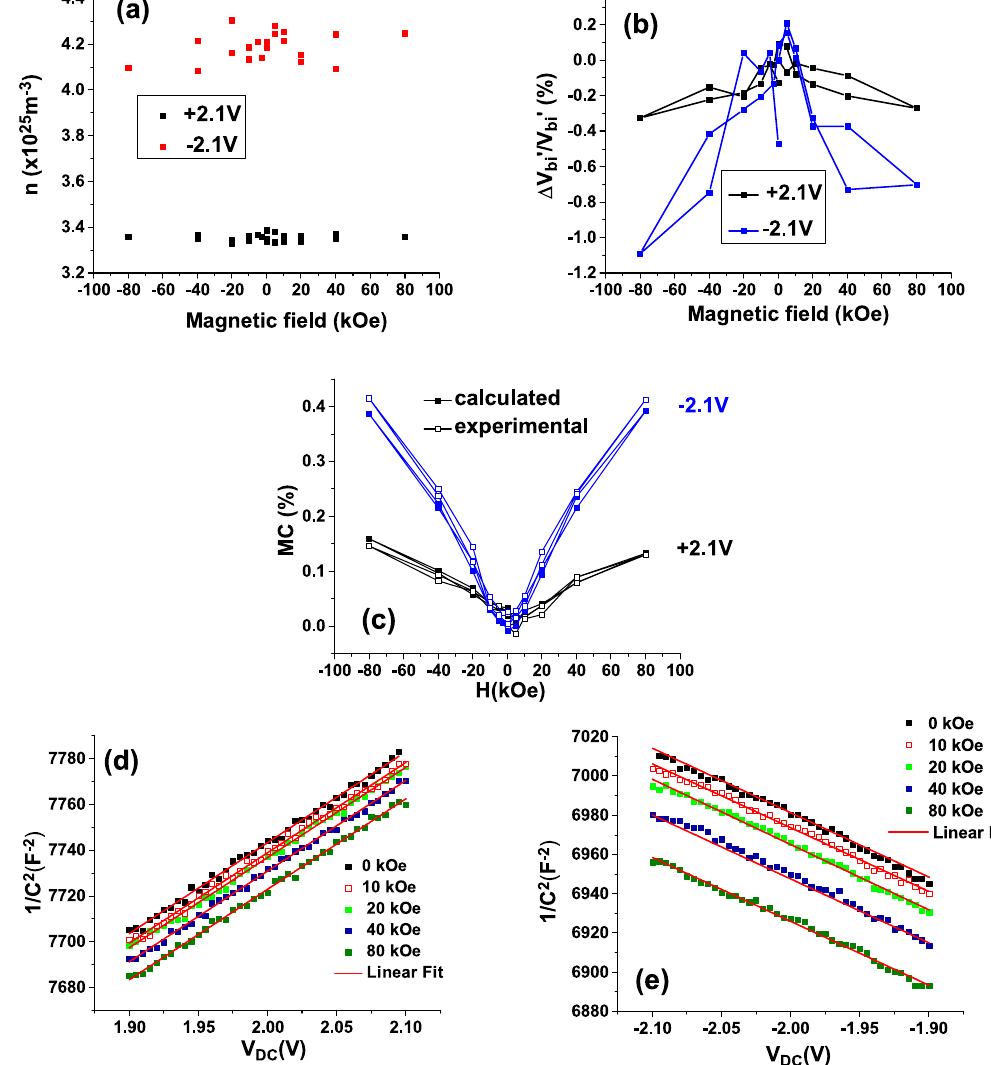
Figure 7. ( a ) Magnetic field dependence of the free carrier concentration and ( b ) of the apparent built-in potential V bi ′ ; ( c ) comparison between the experimental (open symbols) and calculated (full symbols) MC values. The lines shown on ( b ) and ( c ) are only as guides to the eye; ( d ) and ( e ) 1/C 2 vs V DC and the linear